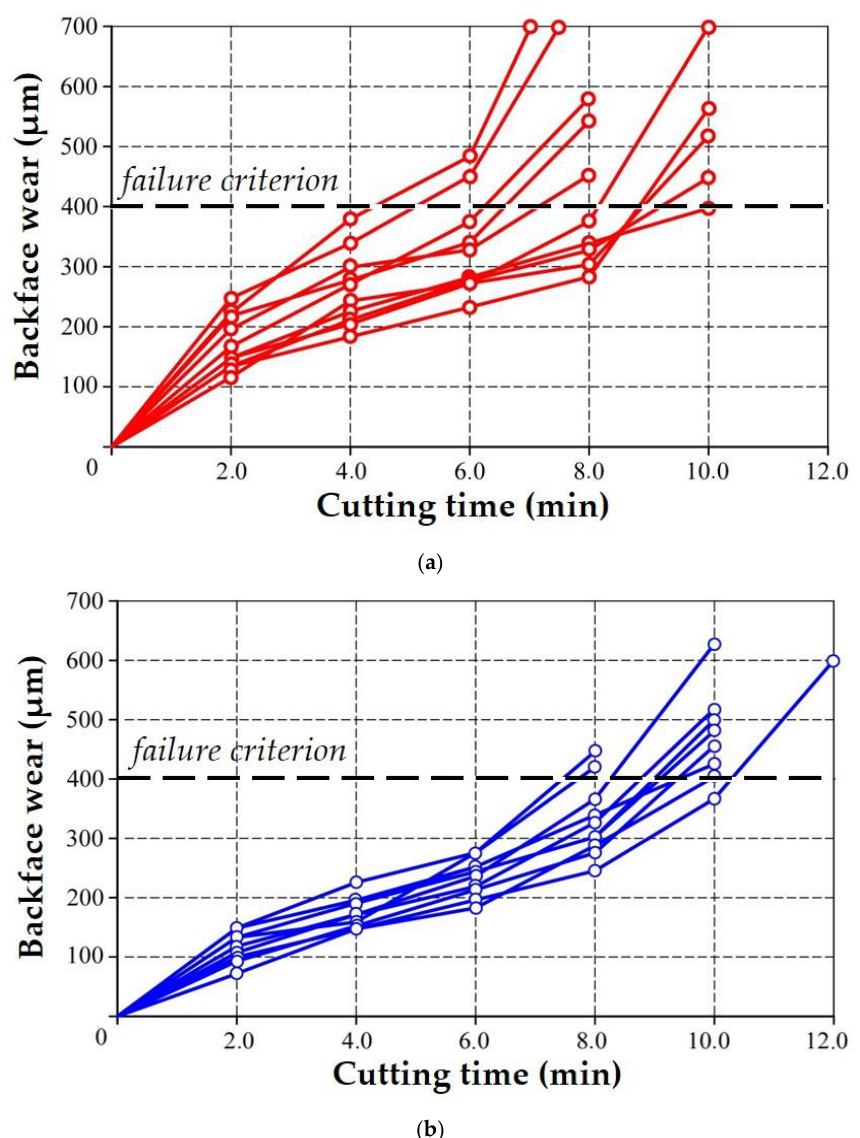
Figure 9. Group of “backface wear–cutting time” curves of the cutting faces of SiAlON ceramic inserts after diamond grinding ( a ), and diamond grinding, lapping, and polishing ( b ) when turning XH45MBTJuBP heat-resistant nickel alloy (V = 300 m/min, S = 0.2 mm/rev, t = 0.8 mm).